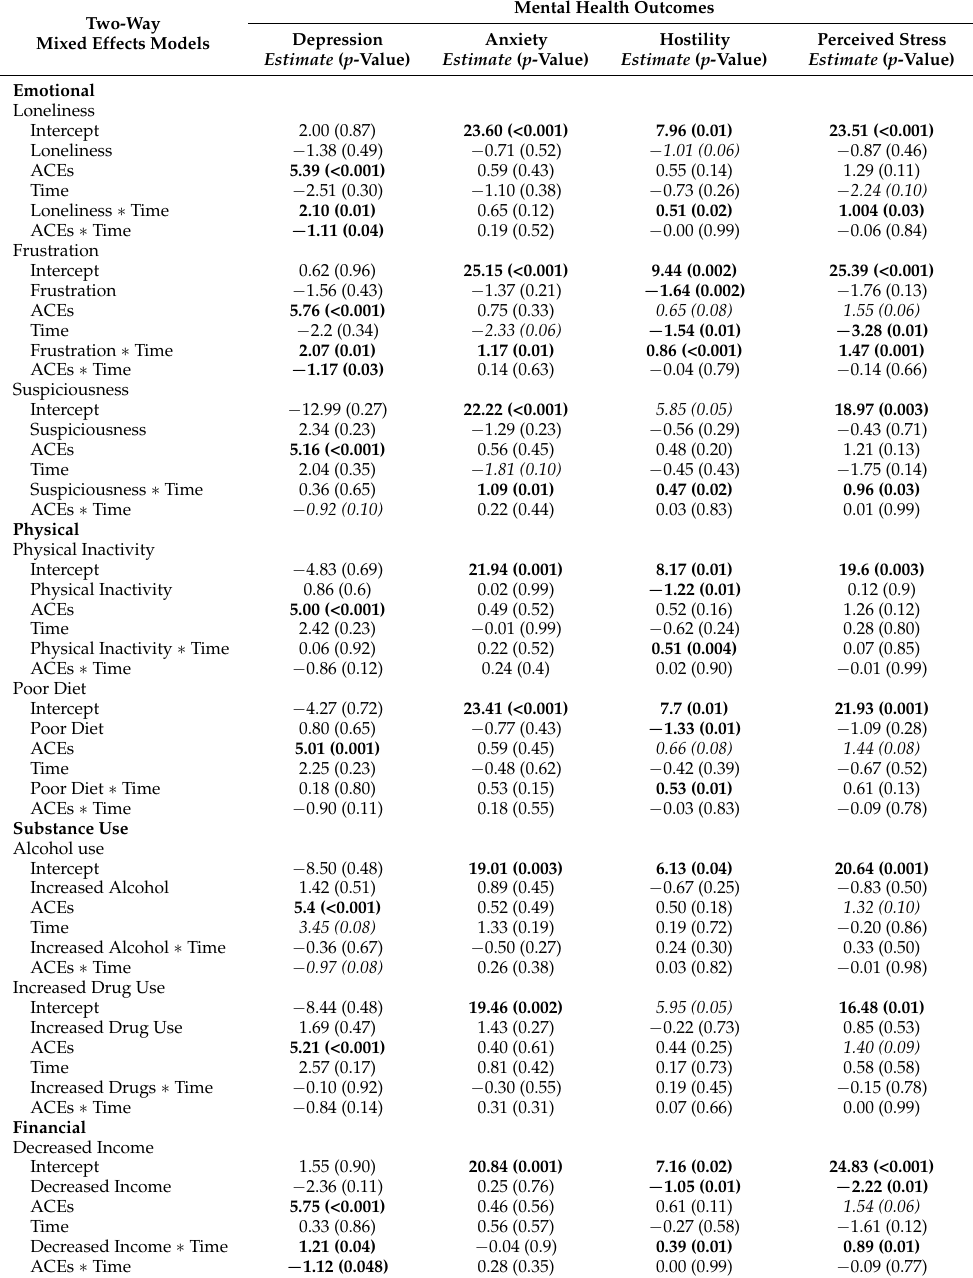
Table A1. Two-way Longitudinal Mixed Effects Regression Models Predicting Changes in Mental Health Outcomes by COVID-19 Proximal Stressors and Exposure to ACEs with